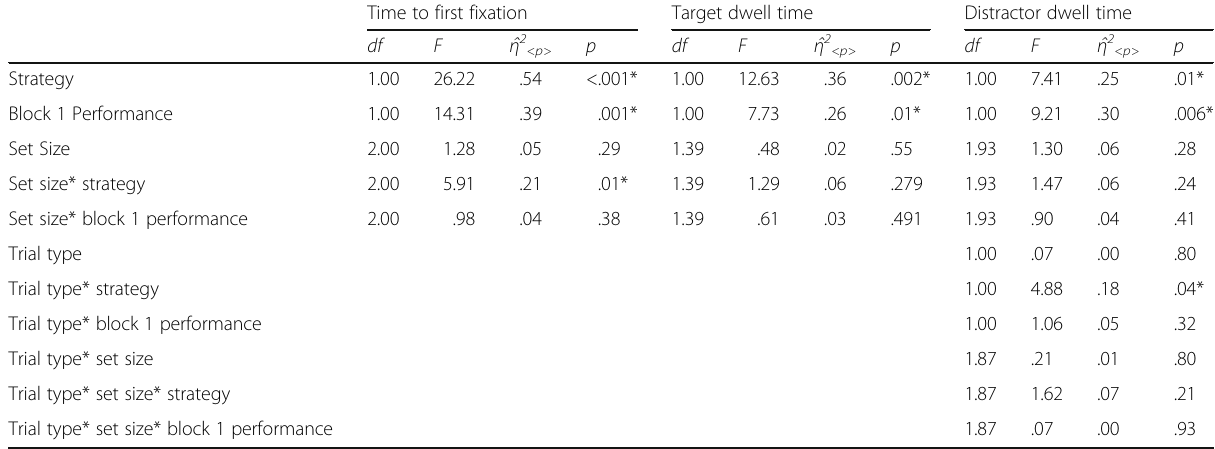
Table 4 Full results of analysis of covariance (ANCOVA) for oculomotor behavior in experiment 2 (cont.) Time to first fixation Target dwell time Distractor dwell time